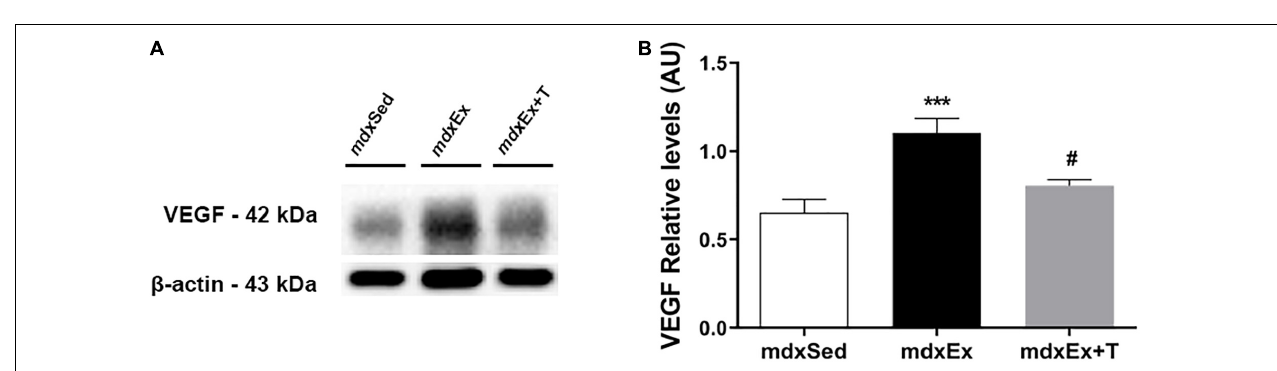
FIGURE 8 | Tempol effects on the VEGF factor. (A) Western blotting analysis of the vascular endothelial growth factor (VEGF) content in the diaphragm (DIA) muscle from the sedentary mdx mice (mdx Sed), exercise trained mdx mice ( mdx Ex), and exercise trained mdx mice treated with Tempol ( mdx Ex+T). The blots of the proteins (top row) and β -actin (loading control, bottom row) are shown. (B) The graphs show the protein levels in the crude extracts of DIA from the mdx Sed, mdx Ex, and mdx Ex+T groups. The intensities of each band were quantified and normalized to those of the corresponding control. All values expressed as mean ± standard deviation (SD). *** P ≤ 0.0001 compared with the mdx Sed group, # P ≤ 0.05 compared with the mdx Ex group (one-way ANOVA with Tukey’s post hoc test).